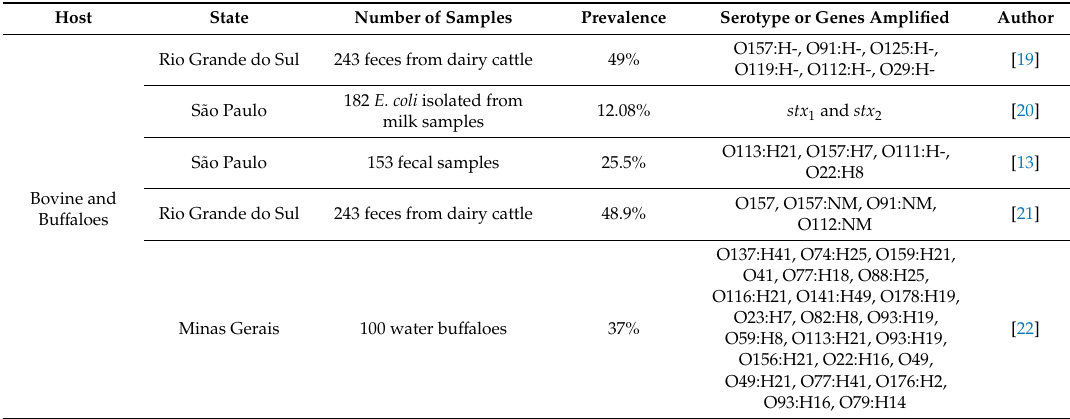
Table 1. Prevalence of Shiga toxin-producing Escherichia coli (STEC) isolated in animals reared in Brazil.